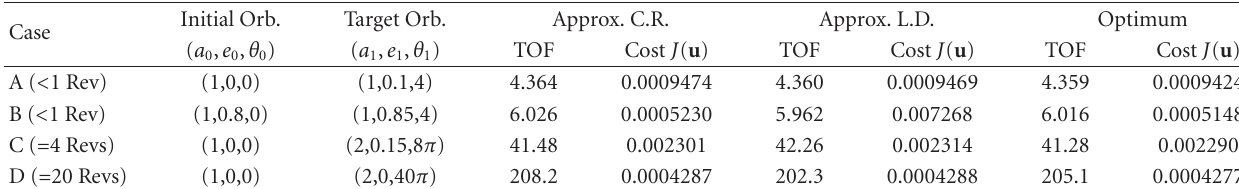
Table 1: Numerical tests of approximate